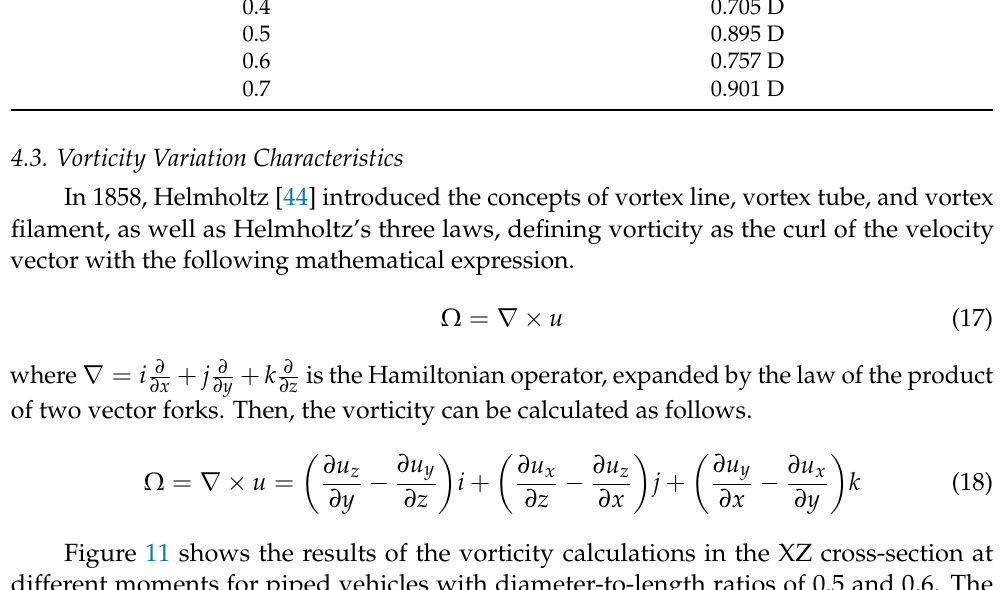
Figure 10. Dimensionless, time-averaged downstream velocity distribution cloud in XZ plane and dimensionless, time-averaged downstream velocity variation curve along center line of pipe: ( a ) K = 0.4; ( b ) K = 0.5; ( c ) K = 0.6; ( d ) K = 0.7. Table 2. Backflow area lengths for piped vehicles with different diameter-to-length ratios.